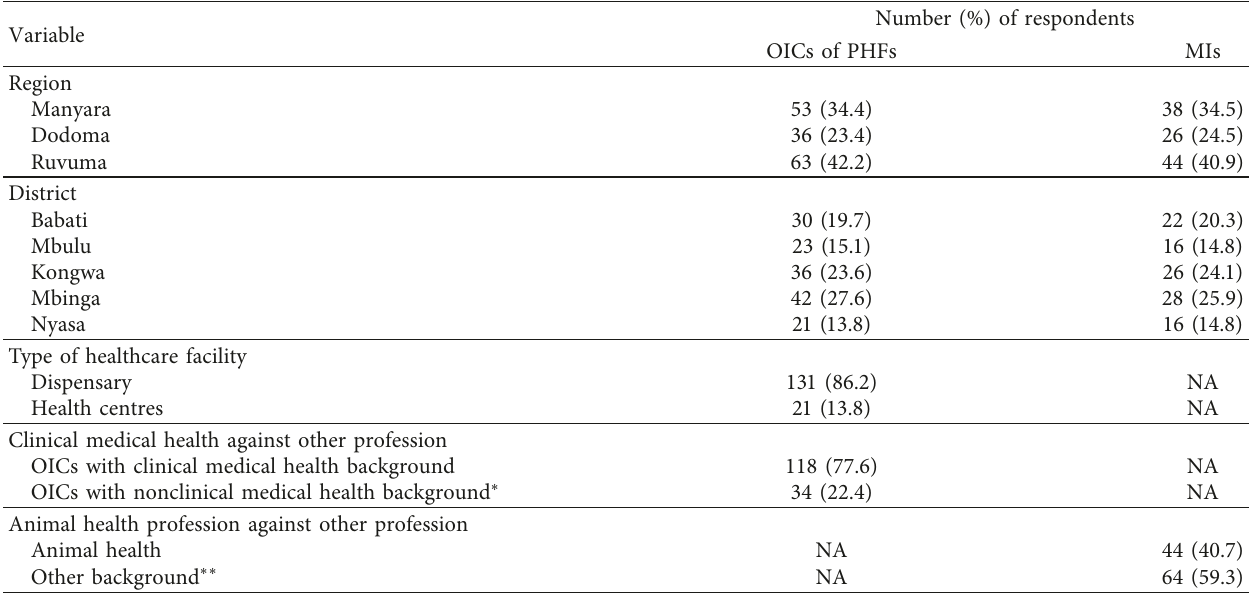
Table 1: Geographical and professional characteristics of respondents.